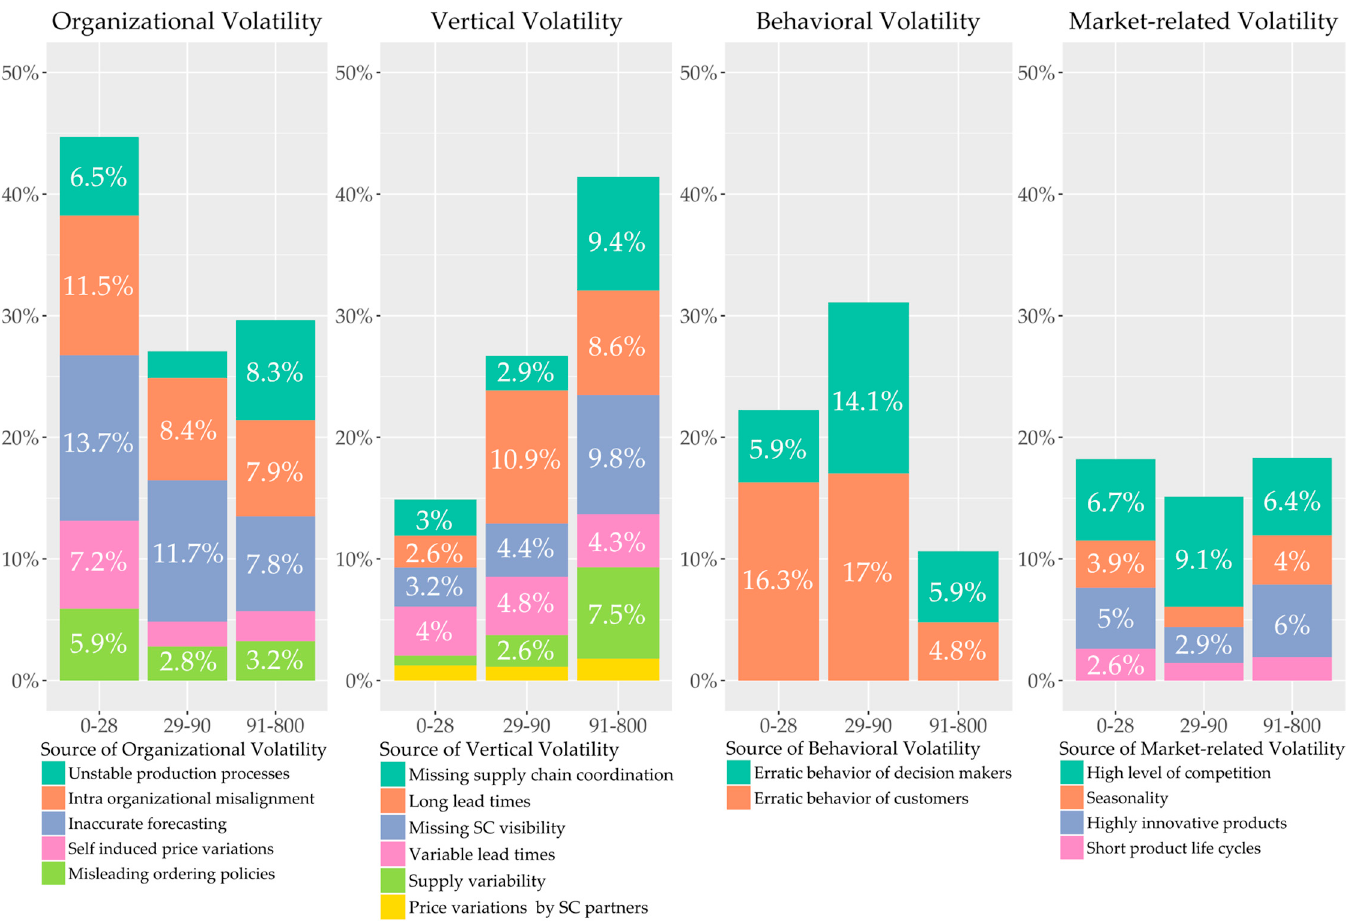
Figure 4. Impact of SCV sources on SCV analyzed by length of lead time (in days).